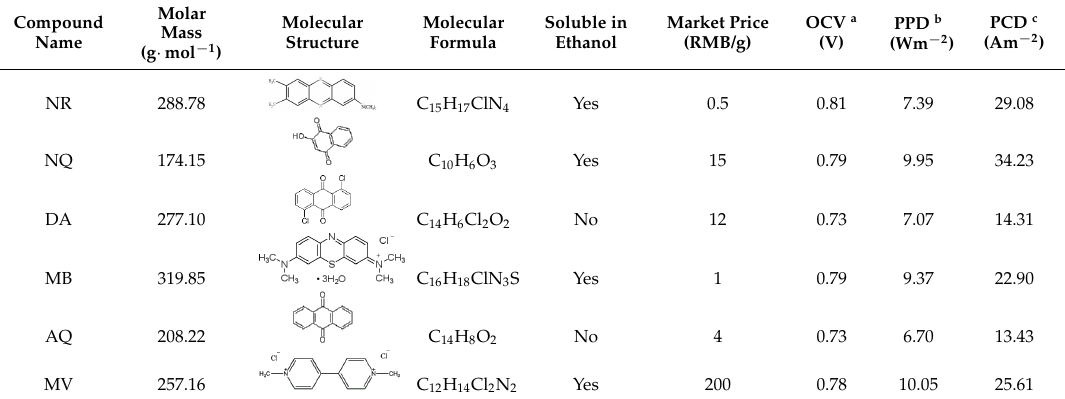
Table 1. Comparison of six compounds to function as electron mediators: molar mass, molecular structure, molecular formula, soluble in ethanol solution, market prices, and their corresponding fuel cell performance.